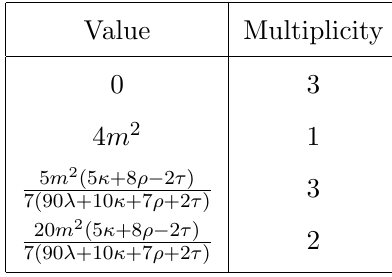
Table 2 . Scalar mass eigenstates for the SSB pattern SO(3) ! S 4 using a real 9 of